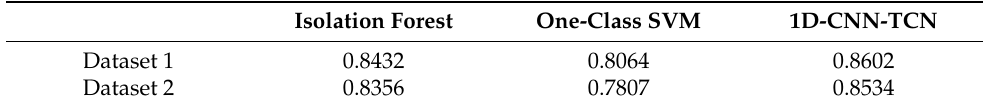
Table 10. F1-score evaluation results of different methods.